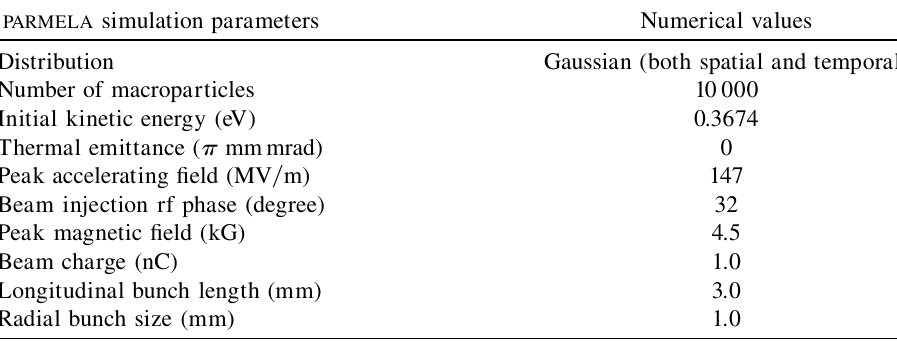
TABLE III. PARMELA simulation parameters of the electron beam.